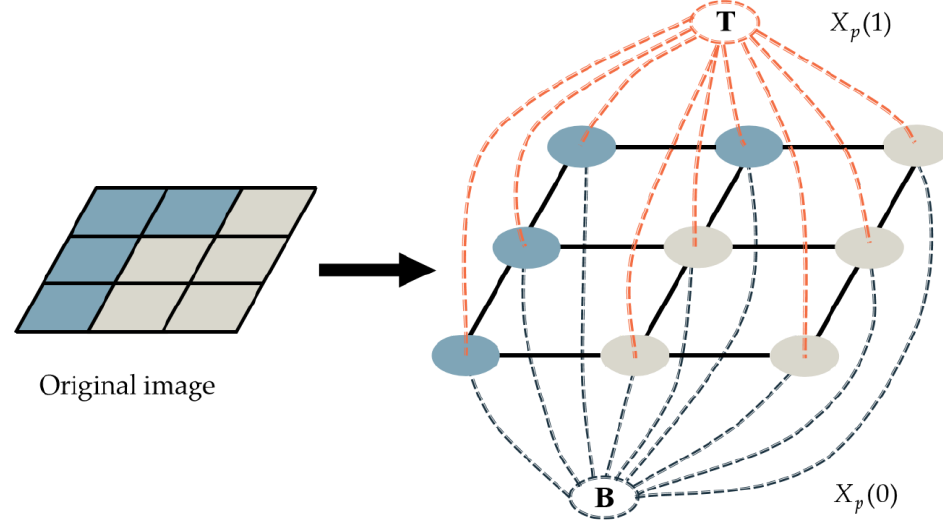
Figure 2. The t-b diagram of graph cuts. The solid lines represent m-links, connecting the neighboring vertices of the image, and the dotted lines represent n-links, connecting the terminal vertices.